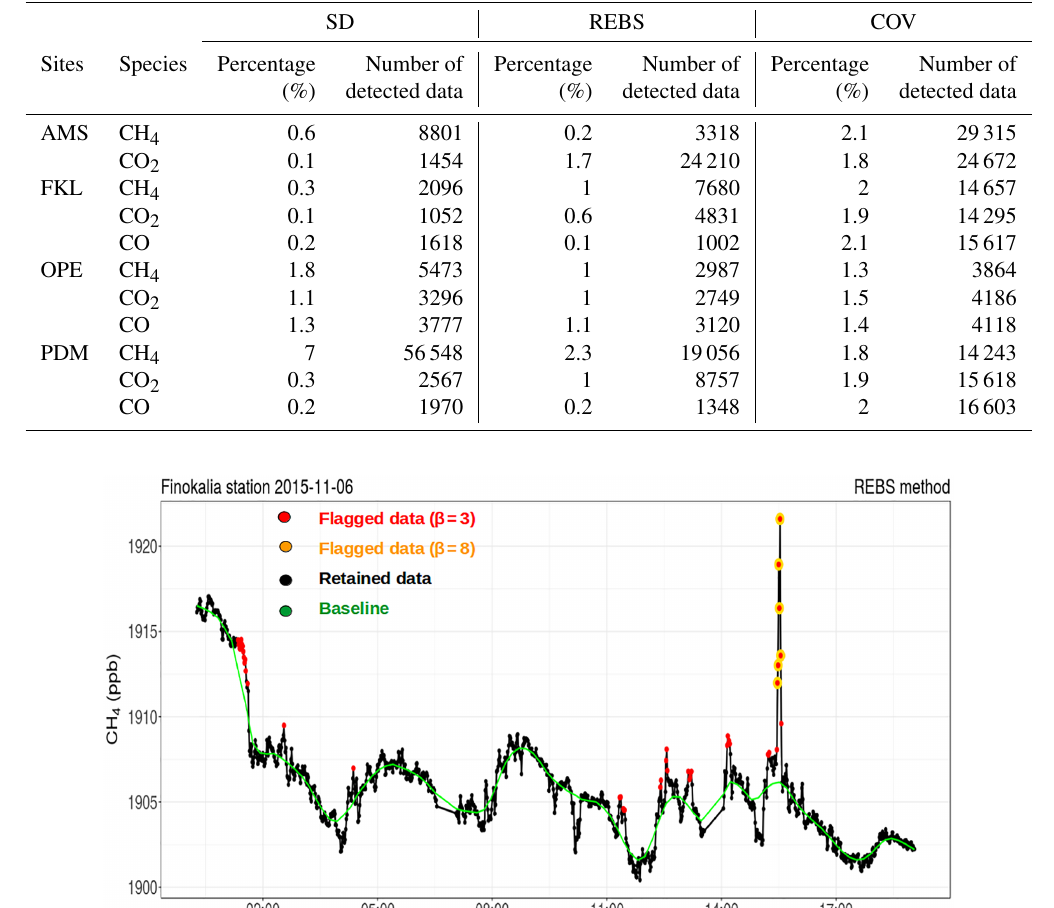
Table 4. Percentage (rounded to one decimal) and number of contaminated data detected by SD, REBS and COV method overall stations (AMS, FKL, OPE and PDM) and for the three species CO, CO 2 and CH 4 .